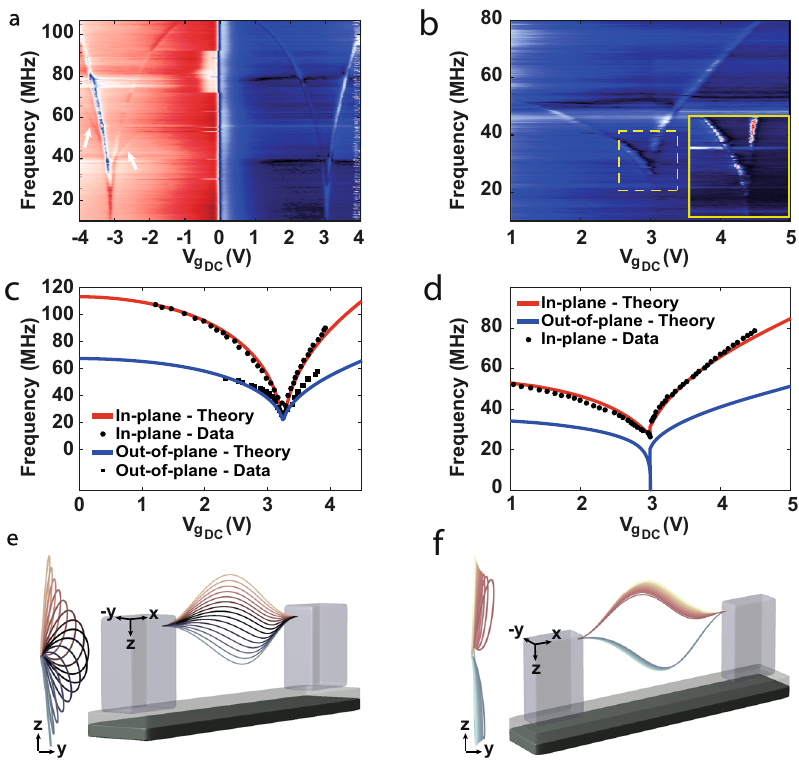
Fig. 3 | Hybrid in-plane and out-of-plane motion. a Resonance frequency mea- surement of device VII, revealing both the out-of-plane (lower, marked by the arrows) and in-plane (second) modes where b c ≤ b 0 <0. b Resonance frequency measurement of device VIII, in which b 0 <b c <0. Only the lowest in-plane mode is detected. Inset is a close-up of the “ jump ” area marked by the dashed line. a “ jump ” intheresonancefrequencyevenbeforereachingzero(device